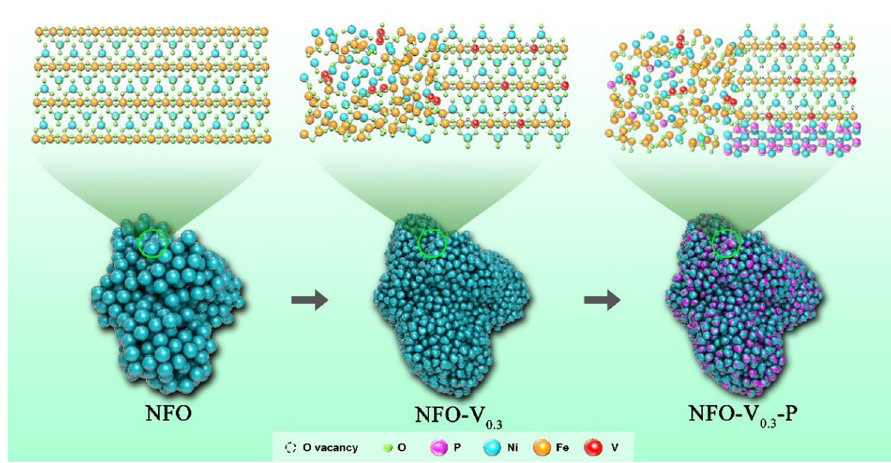
Figure 1: Catalyst preparation process